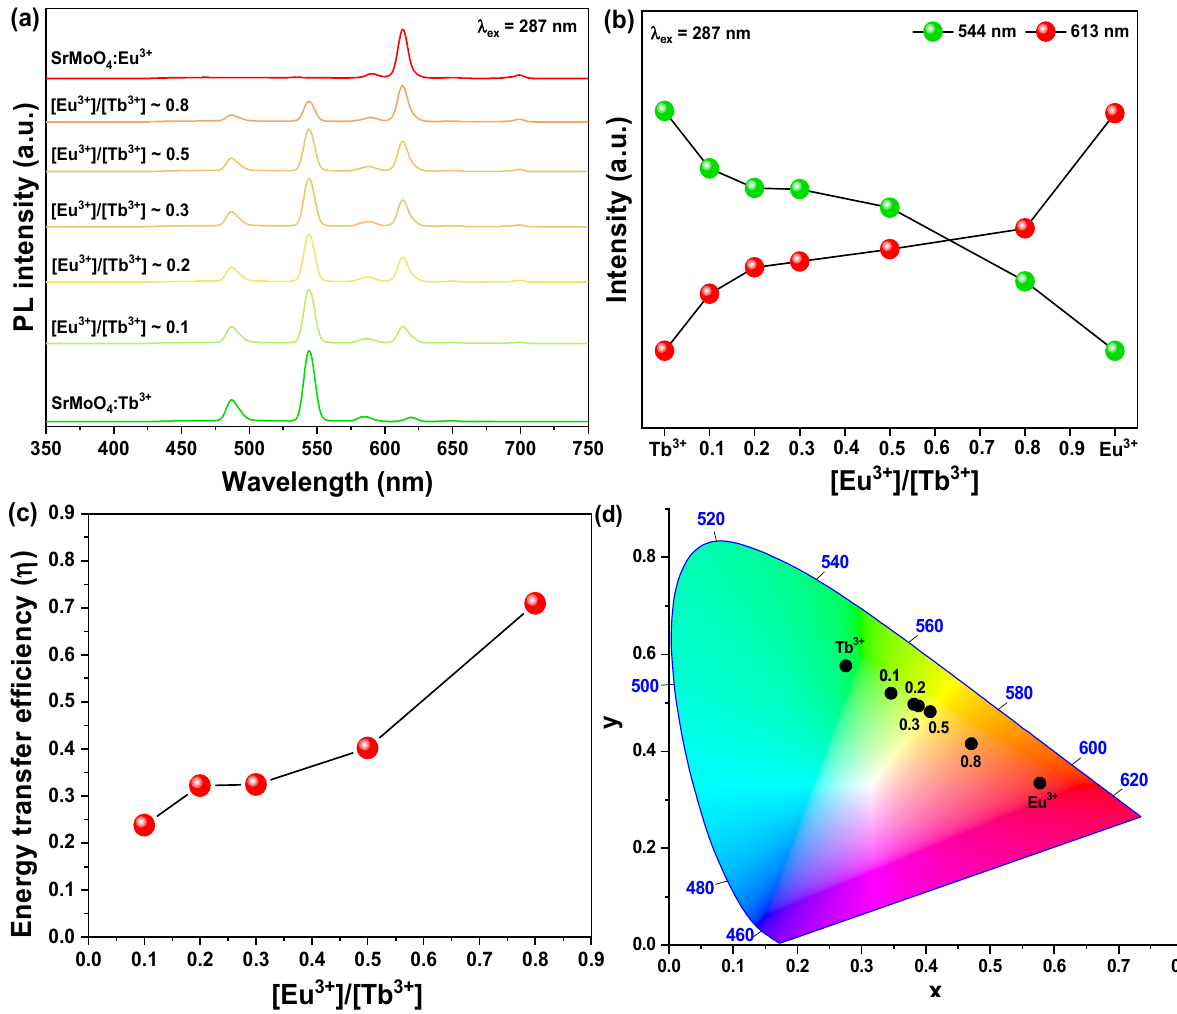
Figure 7. ( a ) PL spectra of SrMoO 4 :[Eu 3+ ]/[Tb 3+ ] under 287 nm, ( b ) change of 544 nm and 613 nm, ( c ) energy transfer efficiency of Tb 3+ to Eu 3+ , ( d ) CIE coordinates of SrMoO 4 :RE 3+ .